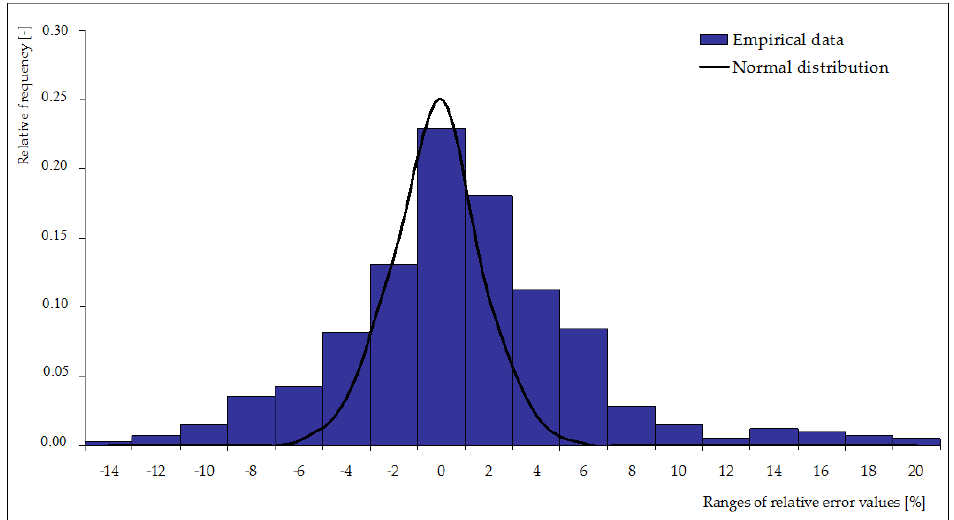
Figure 12. Distribution of errors in estimating the maximum queue size at signal-controlled intersection approach obtained by the proposed model.